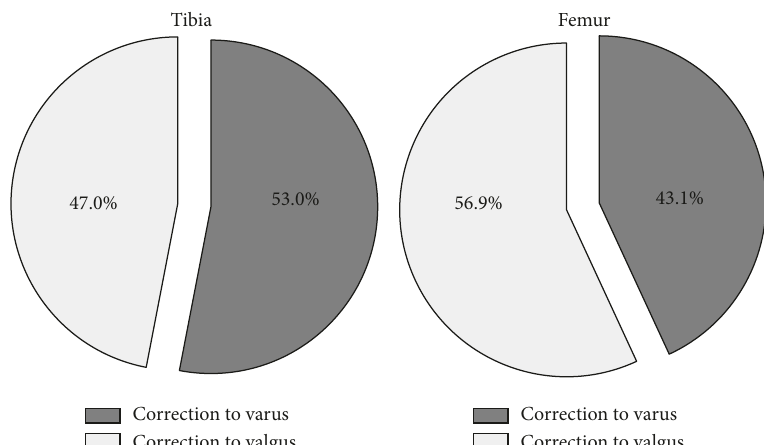
Figure 4: Change of surgical procedure, presented as percentage for the femoral and tibial bone resection, separately. The direction of the required correction is shown.